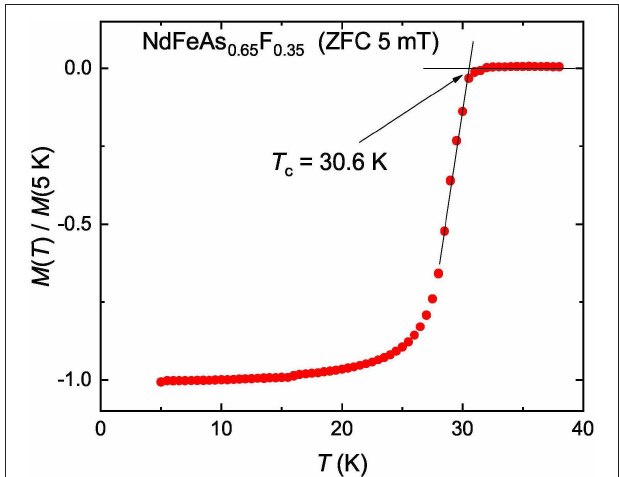
FIGURE 1 | The zero-field cooled magnetization curve [ M ( T ) curve] measured on about thirty NdFeAsO 0.65 F 0.35 single crystals, which were further used in µ SR experiments. The external magnetic field B ex the ab -plane of the crystals. The M ( T ) data were normalized to their M ( T 5 K) value. =